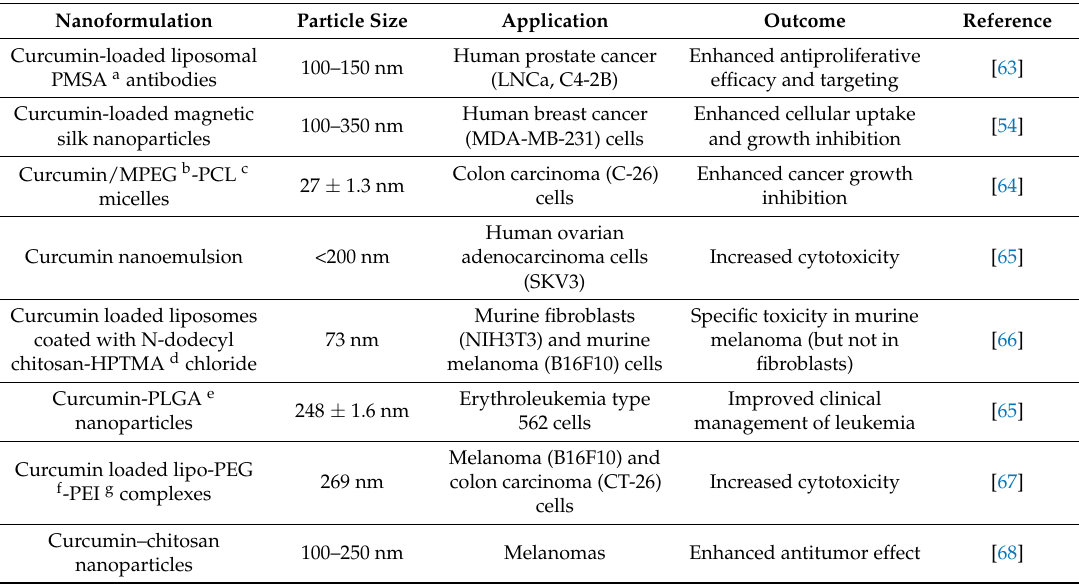
Table 2. Examples of recent curcumin delivery